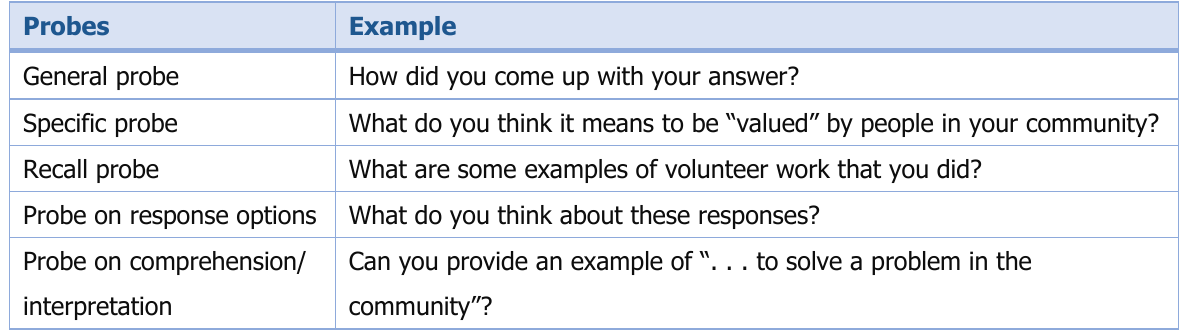
Table 1. Examples of Probes Included in the Interview